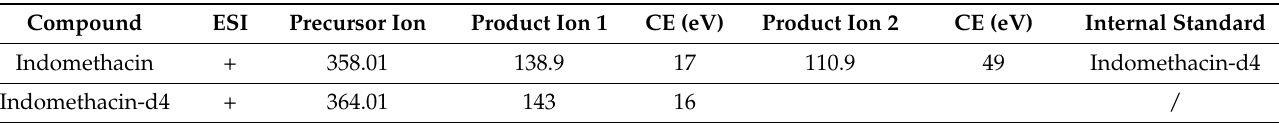
Table 3. MS/MS parameters of indomethacin analyses. Positive ion mode was used in elestrospray ionization (ESI).